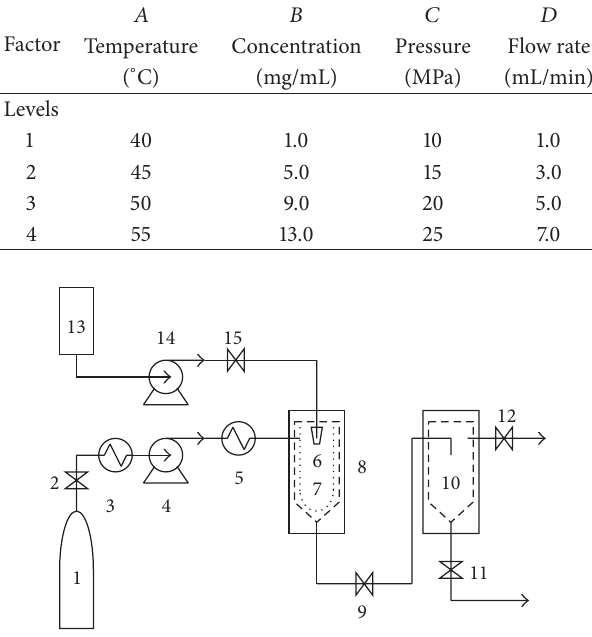
Figure 2: Flow diagram of the supercritical antisolvent